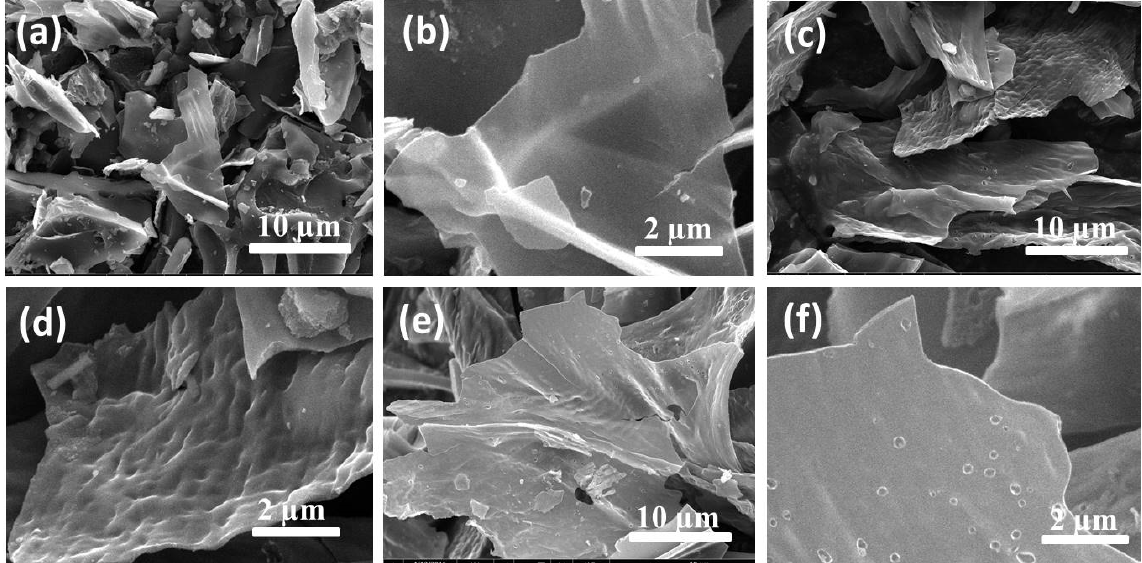
Figure 1. SEM images of ( a , b ) HPC-700, ( c , d ) HPC-800, and ( e , f ) HPC-900.